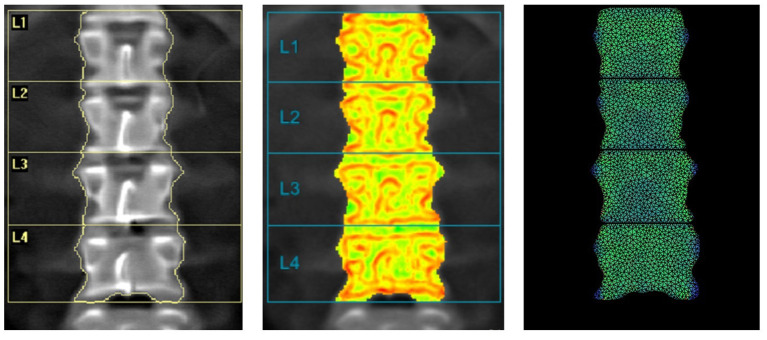
Example of images provided by DXA: BMD L1L4 = 0.868 g/cm2 (left); TBS L1-L4 = 1.361 (center) and BSI L1L4 = 1.57 (right).